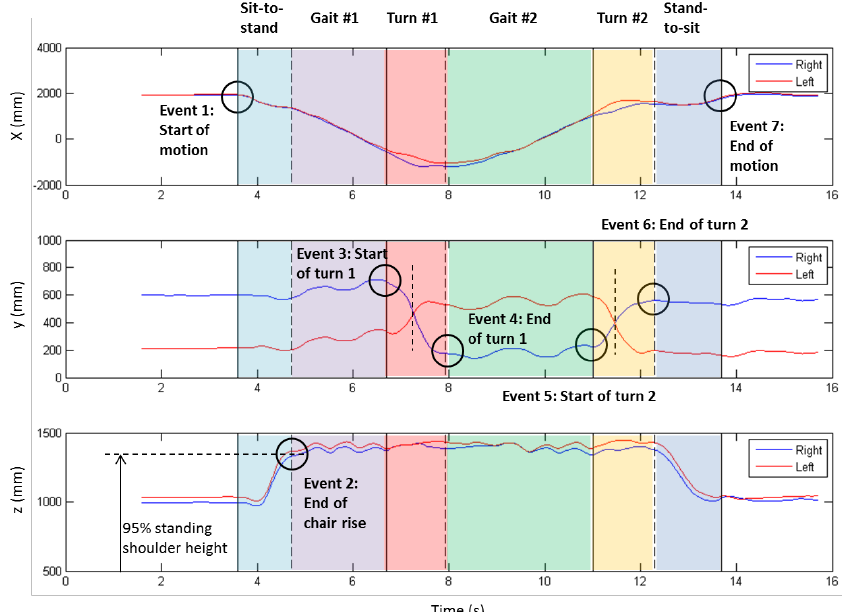
Figure 2. TUG event time determination from motion capture markers on the right and left shoulders. Top: X (anterior/posterior) coordinate is used to detect the start (event 1) and end of movement (event 7). Bottom: Z (superior/inferior) coordinate is then used to detect the end of the sit-to-stand (event 2) when the shoulder marker first exceeds 95% of the standing shoulder height. Middle: The two turns were then detected using the Y (medio/lateral) coordinate, from first locating the cross-point of the left/right shoulder markers (shorted vertical dashed lines), and then locating the maxima and minima before and after (or vice versa depending on turn direction) to define the start (events 3 and 5) and end (events 4 and 6) of the turns.